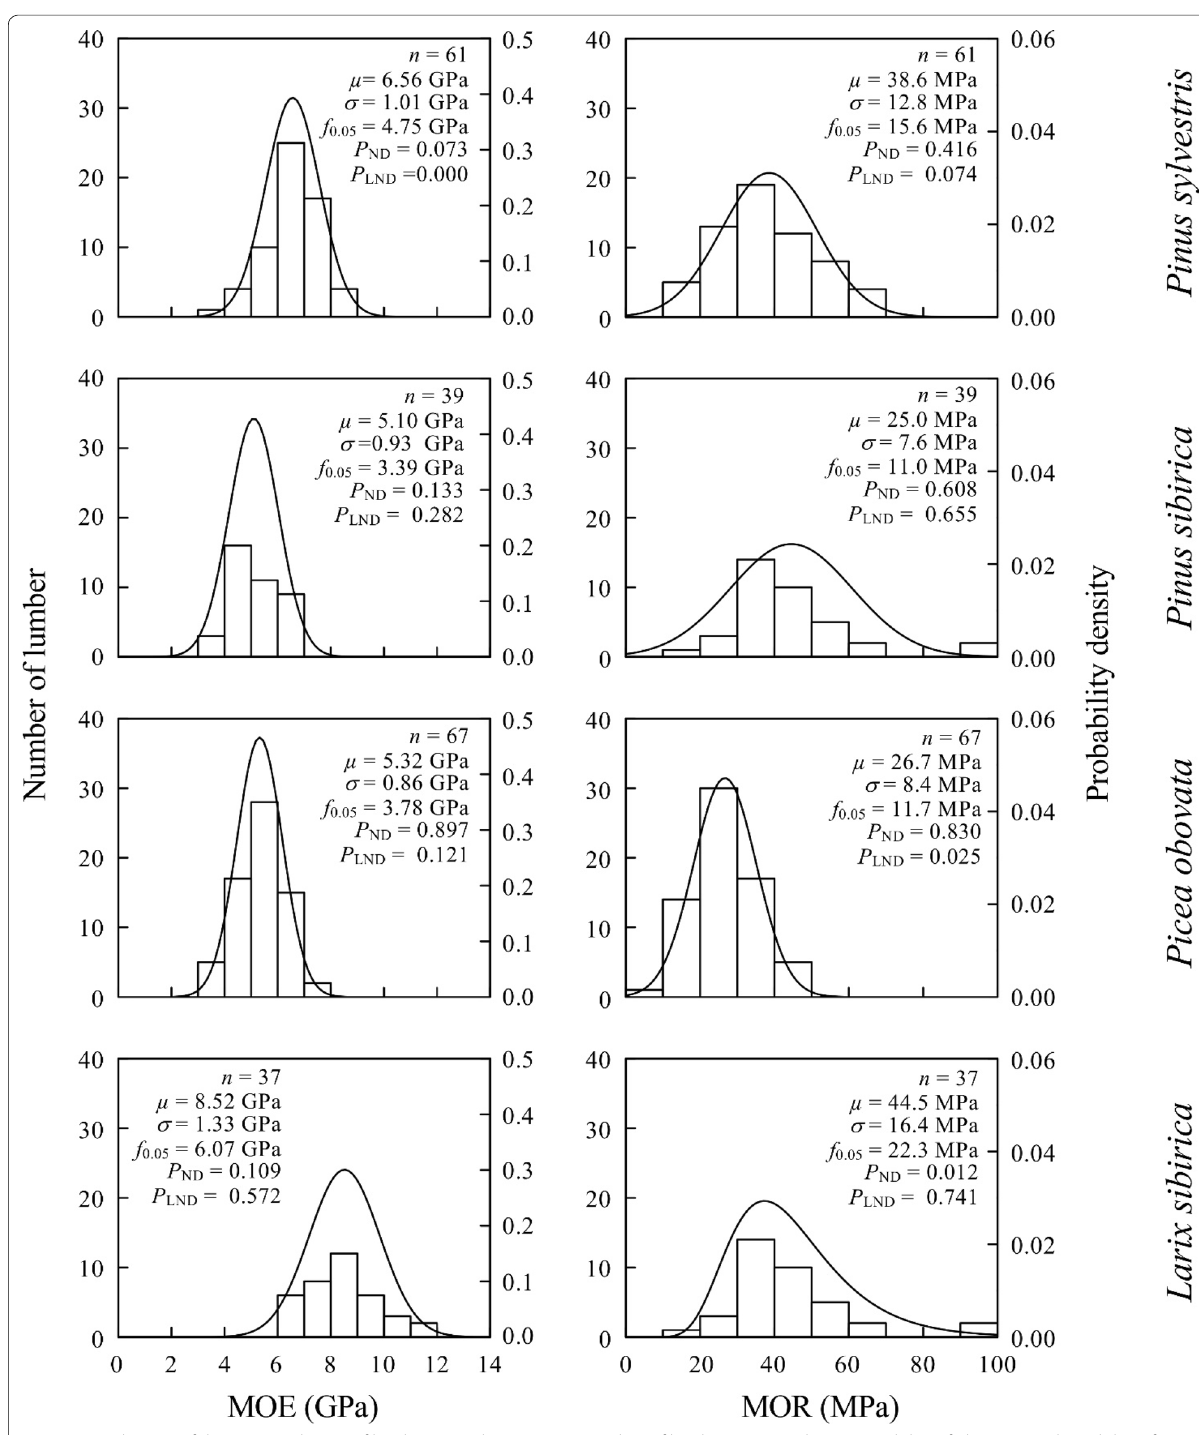
Fig. 2 Distribution of the MOE and MOR of lumber in each species. n , number of lumber; MOE and MOR, modulus of elasticity and modulus of rupture adjusted to the values at 15% moisture content by the methods described in Japan Housing and Wood Technology Center [27]; μ , mean value; σ , standard deviation; f 0.05 , the 5% lower tolerance limit with a 75% confidence level; P , probability obtained by Shapiro–Wilk test as test of normality of normal distribution (ND) or logarithmic normal distribution